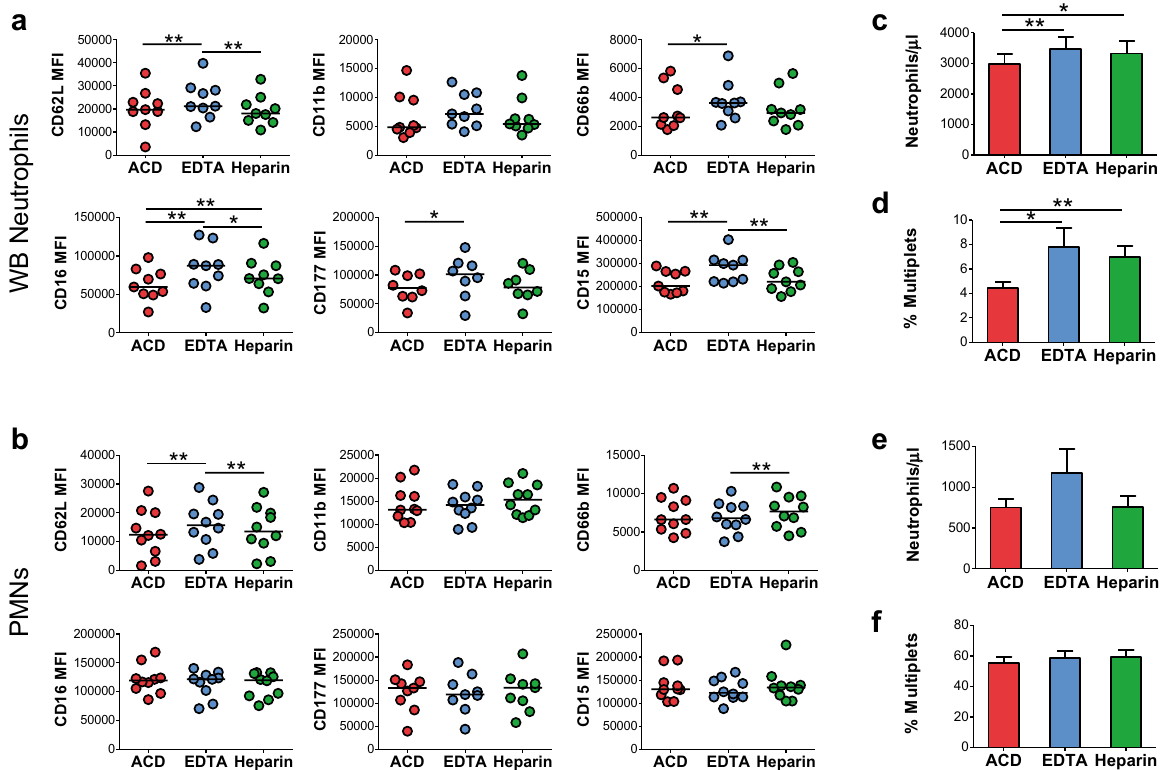
Figure 6. Effects of anticoagulant type on neutrophil phenotype and recovery. ( a , b ) Levels of surface proteins on neutrophils from ( a ) WB or ( b ) PMNs from HDs following collection from the same individual using ACD, EDTA, or heparin tubes. Bars indicate medians. ( c ) Neutrophil recovery per microliter or ( d ) percent multiplets formed by neutrophils from WB collected using the indicated tube types. Bars indicate means/ SEM. ( e ) Neutrophil recovery per microliter or ( f ) percent multiplets formed by neutrophils from PMNs from WB collected using the indicated tube types. Bars represent means/SEM. For all panels, *p < 0.05, ** p < 0.01 by Wilcoxon matched-pairs signed-rank tests, n = 9. All staining was performed at 4